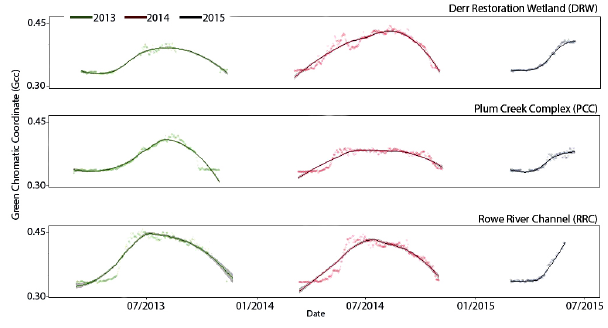
Fig. 3 . Vegetation phenology showing the results of the green chromatic coordinate vegetation index at Derr Restoration Wetland, Plum Creek Complex, and Rowe River Channel for 2013, 2014, and the spring of